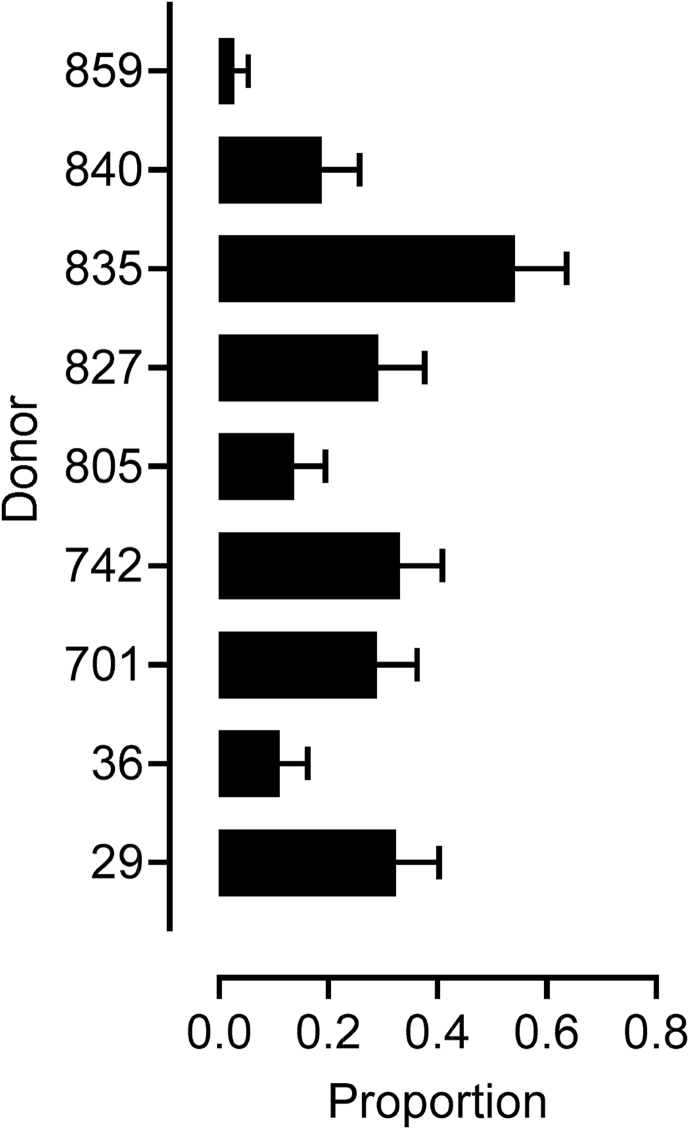
Incidence of aneuploidy in Day 8 blastocysts (all IETS Stage 7–9 blastocysts; n = 152) per donor averaged across stimulated and non-stimulated cycles. The proportion of aneuploid blastocysts differed (P = 0.008) between donors.